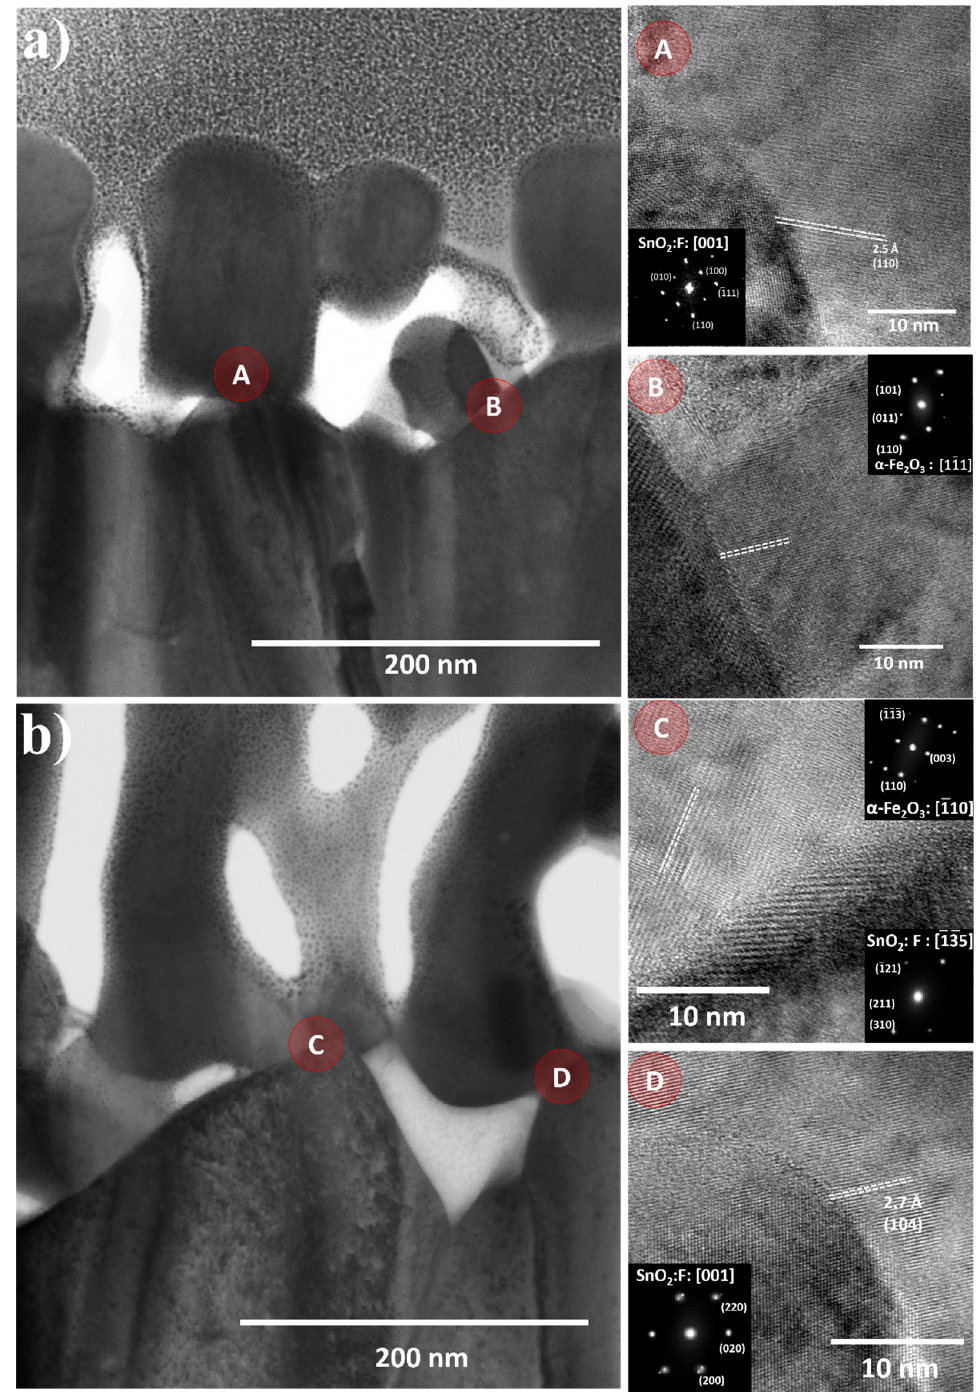
Figure 5. TEM images of the hematite/FTO interface obtained with 500 mg·mL − 1 at ( a ) 5 mT magnetic field and inset show HRTEM images and Fast Fourier Transform images of hematite and FTO (SnO 2 ) indexed with the crystallographic planes along the zone axis of points A and B. ( b ) 50 mT magnetic field, and inset show HRTEM images and Fast Fourier Transform images of hematite and FTO (SnO 2 ) indexed with the crystallographic planes along the zone axis of points C and D.